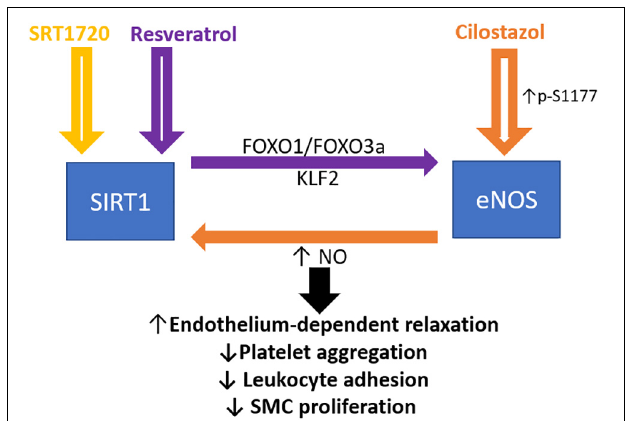
FIGURE 1 | Crosstalk between endothelial SIRT1 and eNOS in mediating endothelial function. Schematic presentation of the current idea on the reciprocal regulation of SIRT1 and eNOS. Resveratrol activates both SIRT1 and eNOS, whereas FOXO1 and FOXO3a are involved in the resveratrol induced eNOS transcriptional activation, based on the published literature (Xia et al., 2013). Cilostazol increases NO production by stimulating eNOS serine 1177 phosphorylation mediated by cAMP/PKA- and PI3K/Akt-dependent pathways. NO, nitric oxide; FOXO, forkhead box O; SMC, smooth muscle cells. KLF2, Krüppel-like Factor